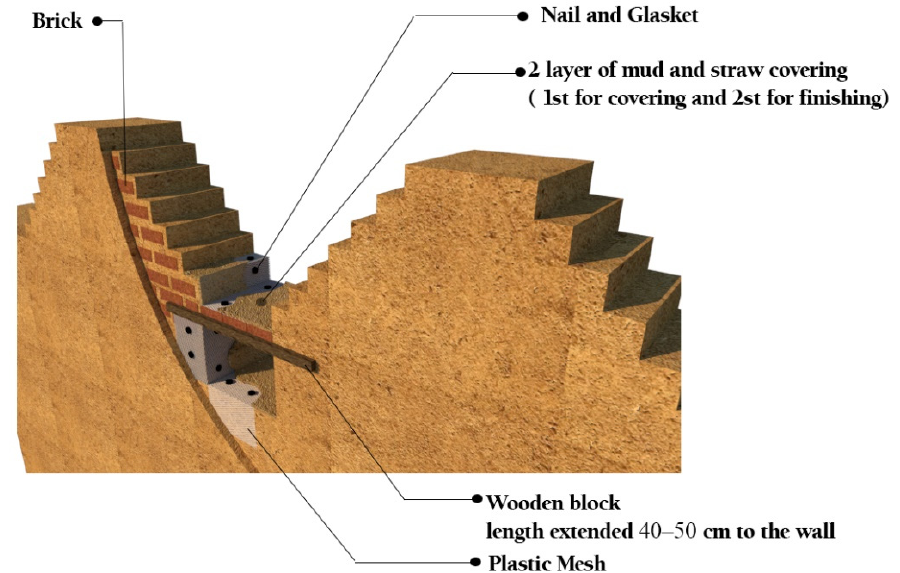
Figure 8. Example of architectural detail for conservation of parapets.